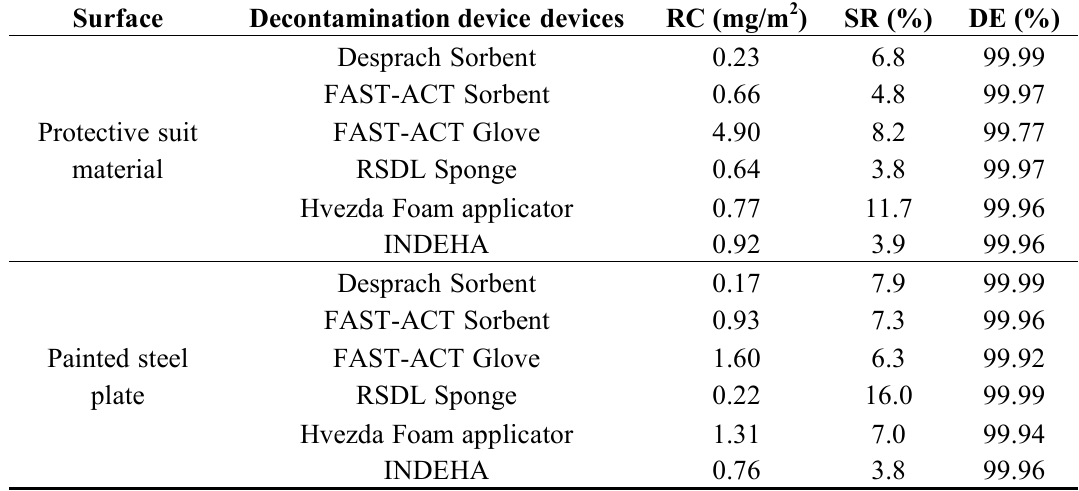
Table 1. Average values of residual surface contamination (RC), relative standard deviation (SR) and decontamination efficiency (DE) for O -ethyl- S -(diisopropyl- aminoethyl)methylthiophosphonate (VX) at an initial contamination level of 2.1 g/m 2 (permissible residual contamination 1 mg/m 2